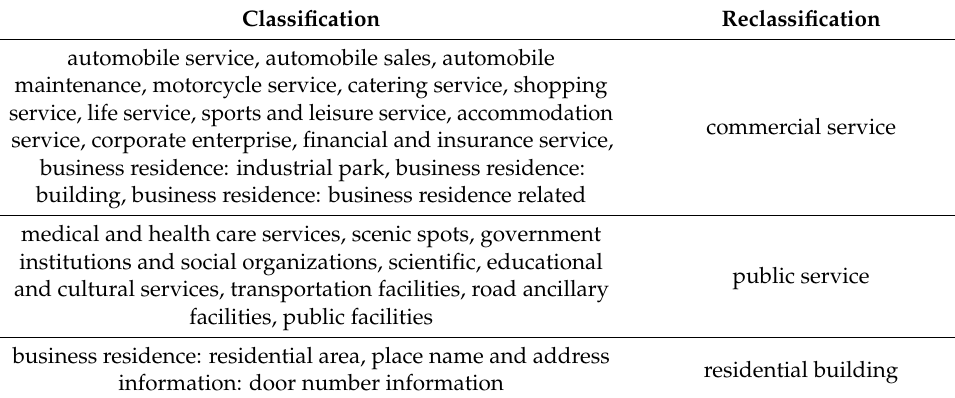
Table 1. Reclassification of POI.